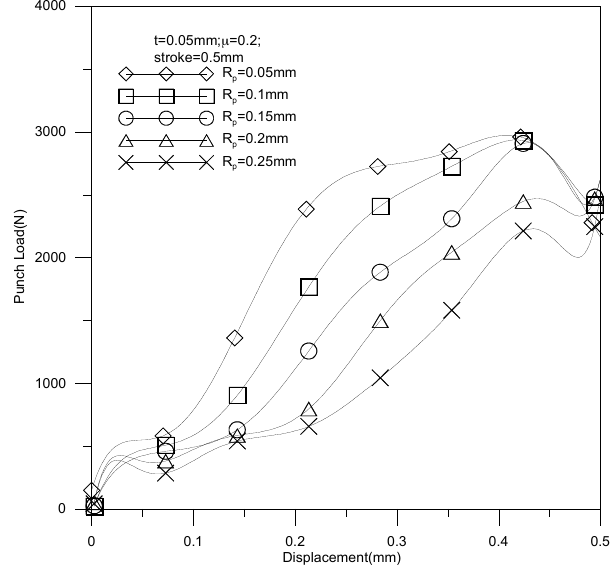
Figure 17. Punch load against stroke under various punch fillet radiuses.